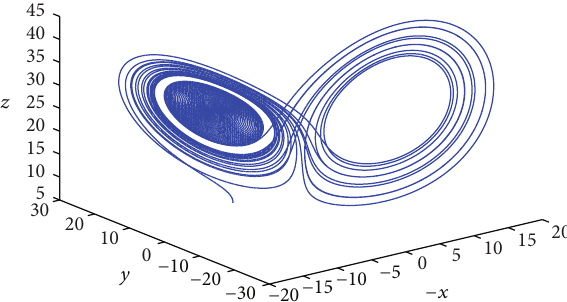
Figure 2: The phase portraits of 𝑥 - 𝑦 - 𝑧 for fractional Lorenz system 𝛼 = 𝛽 = 𝛾 = 0.97 for the case 𝑟 = 1 .